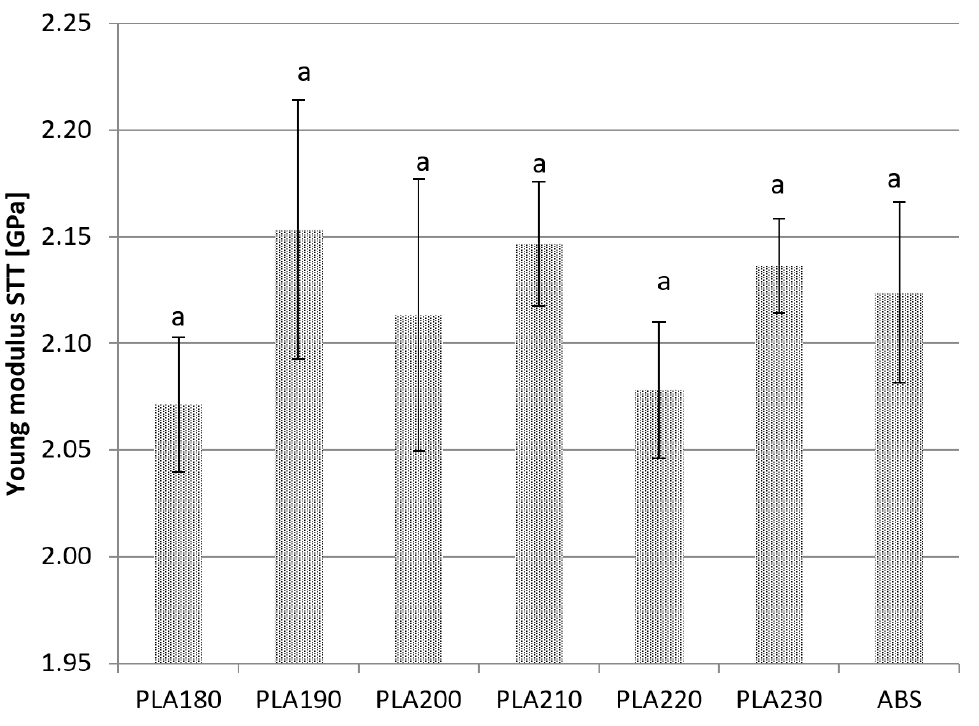
Figure 3. Young’s modulus values measured with STT. Bars with the different letters (a) are signifi- cantly